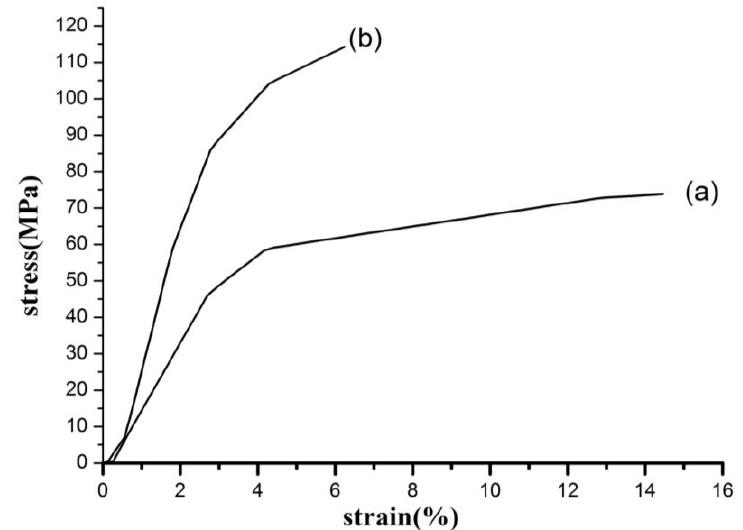
Figure 6. Stress-strain curves of PAN/SWNTs nanofiber sheets with SWNTs concentration 1 wt% before and after being hot-stretched: (a) as-spun; (b) hot-stretched.